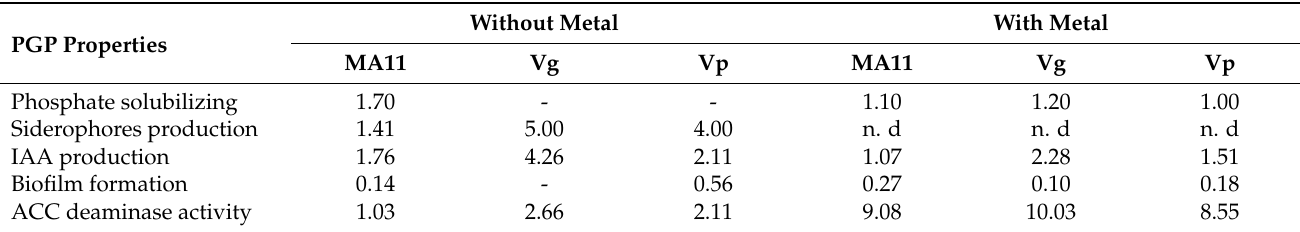
Table 2. PGP properties and enzymatic activities shown by tested